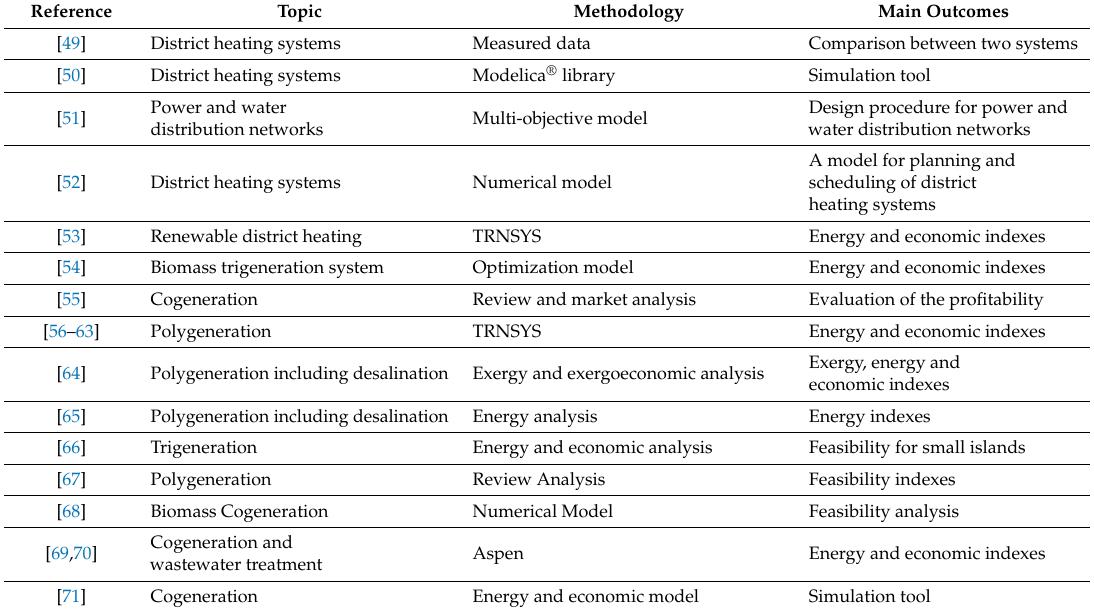
Table 2. Main topics, methodologies and outcomes of the previous SDEWES papers dealing with polygeneration and district